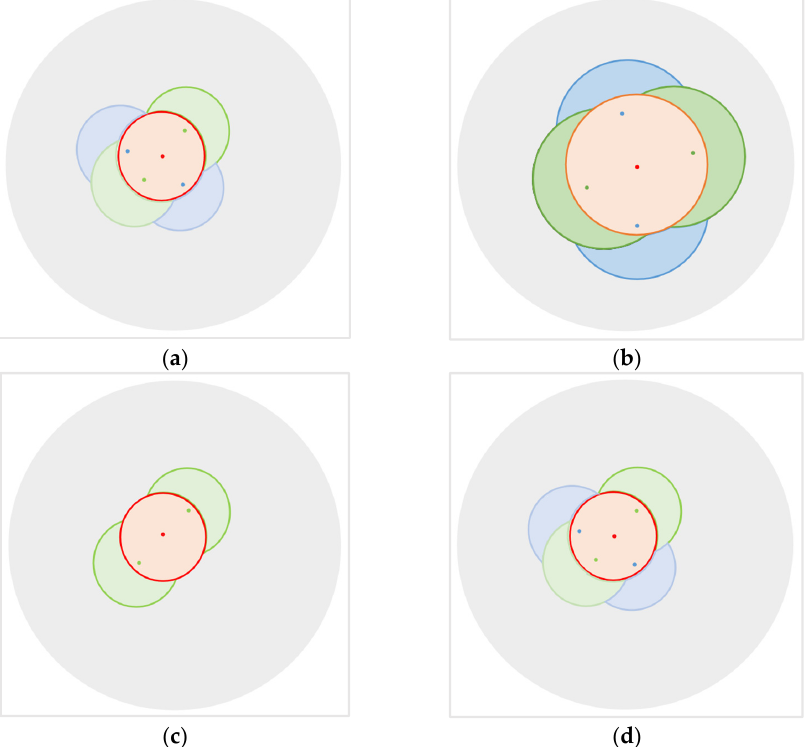
Figure 15. The reason behind computation time difference with the variation of parameters radius and seed number (( a , b ): different radii; ( c , d ): different seed numbers). (Gray: the region within all points; red circle: the neighboring region with the red seed point as the center point; the same goes for other colorful circles )